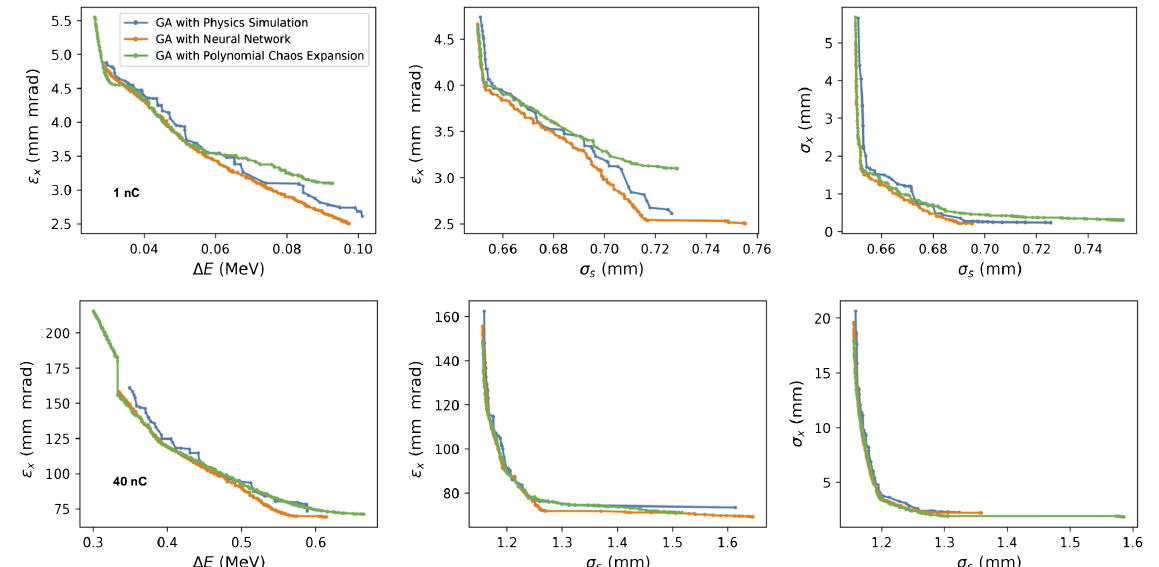
FIG. 11. Comparison of the estimated Pareto front for a PCE model and a NN model. Note that in this case, we use a random sample of 42,000 points (this was from the large initial random sample, which we ran before attempting to scale down to as few sampled points as possible during training). To make a fair comparison in this case, we use the same number of sample points for the NN as we use for the PCE. Note that although the PCE model does not perform as well, it is more straightforward to train, has fewer hyperparameters to tune, and can be used to provide an uncertainty estimate. Although the estimated fronts are less accurate, the points could be used as an initial starting point for a subsequent GA run on the physics